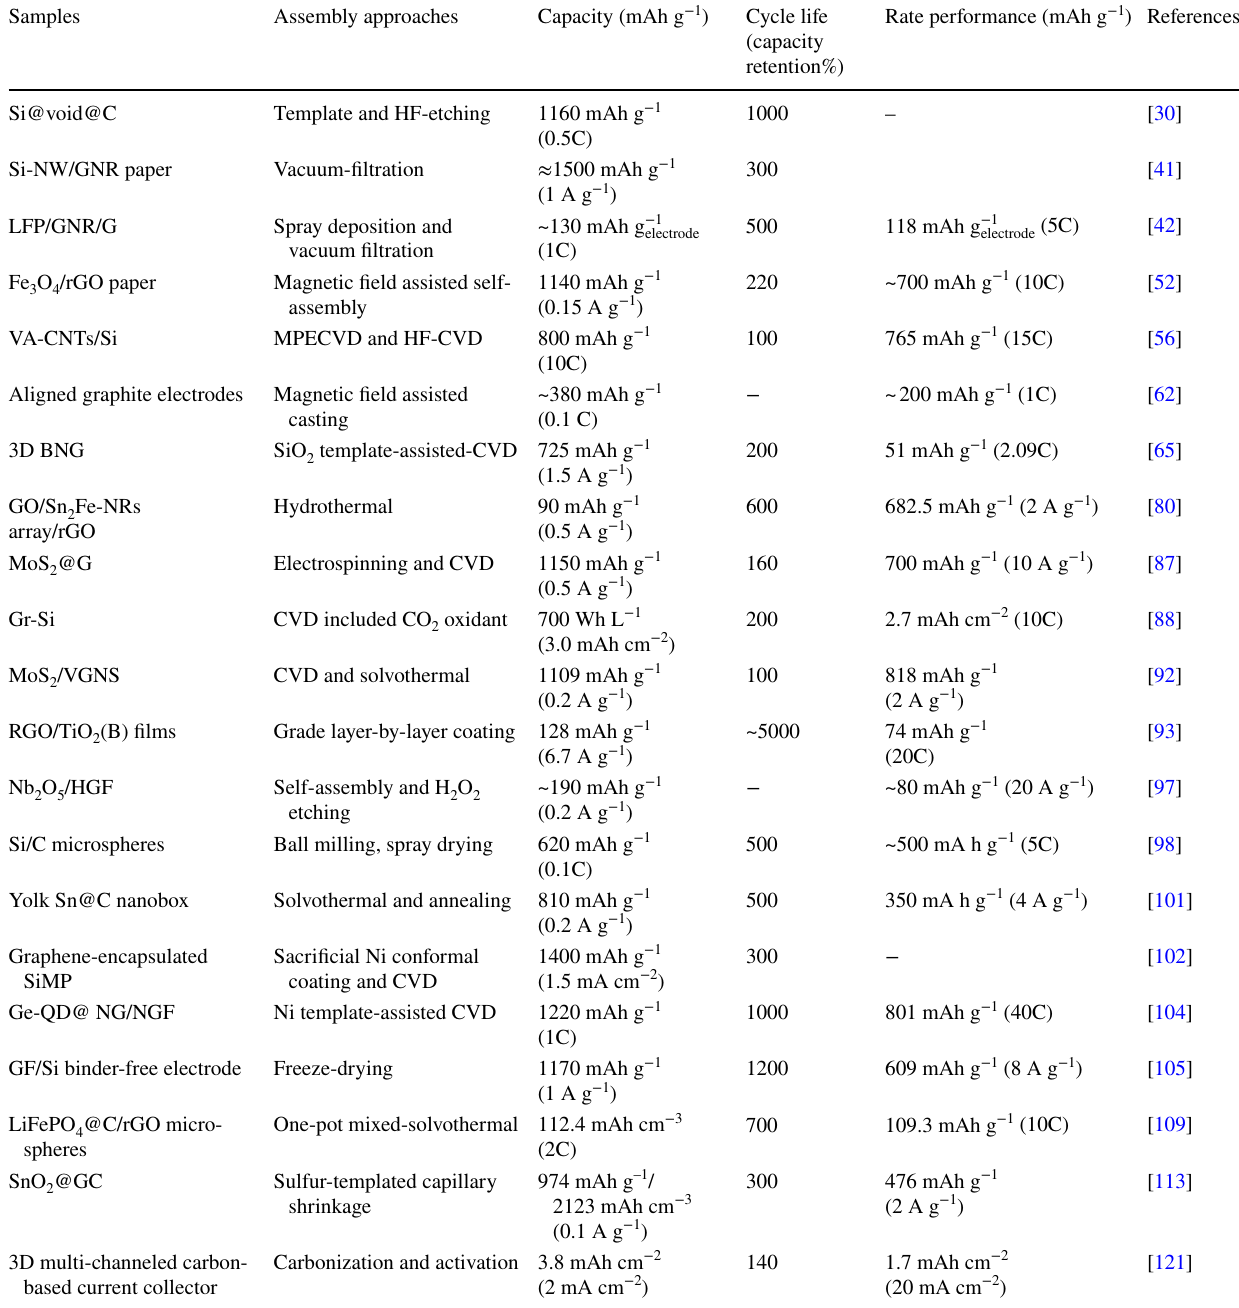
Table 1 Electrochemical performance of typical carbon architectures in lithium‑ion batteries